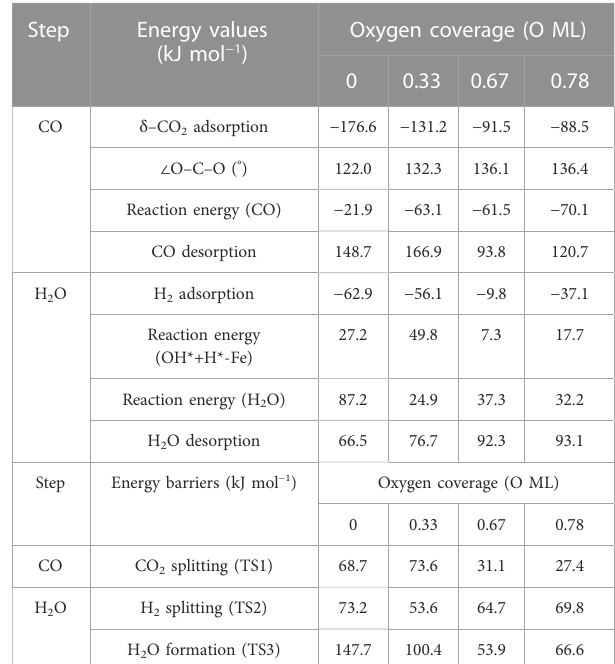
TABLE 1 Summary of energy values (adsorption, release, and overall reaction)